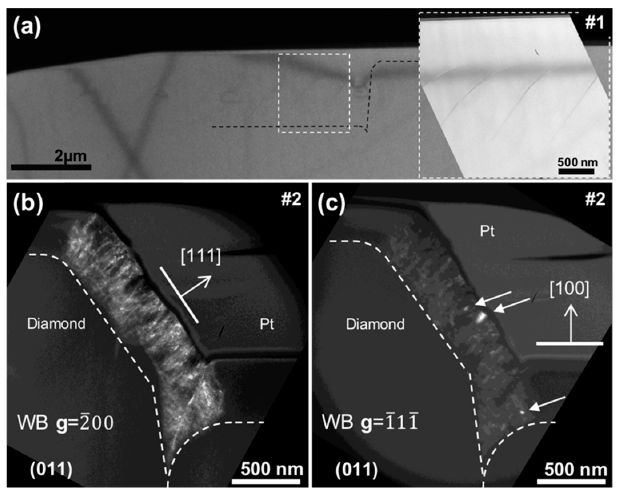
Figure 2. ( a ) Bright-field cross-section micrograph of sample 1 with the lamella oriented along the {011} pole. A black dashed line marks the initial shape of the etched cylinder. The region framed by a white dashed square is enlarged in the right-hand inset. ( b ) Weak-beam micrograph of sample 2 with the lamella oriented along the {011} pole, recorded under two beam conditions using the 200 reflection. Lateral growth orientation is marked by a white arrow. ( c ) Weak-beam micrograph of sample 2 with the lamella oriented along the {011} pole, recorded under two beam conditions using the 111 reflection. Three white arrows mark dislocations invisible in the 200 reflection. White dashed lines mark the initial shape of the etched truncated cone (“disk”) in both micrographs. The vertical (and defect-free) [001]-oriented growth is also marked by a white arrow.